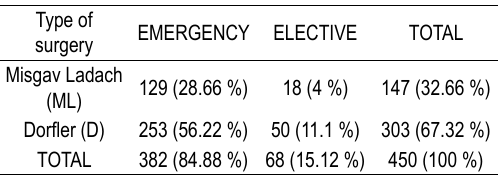
Table 1. frequency of types and ways of performing of cae- sarean sections